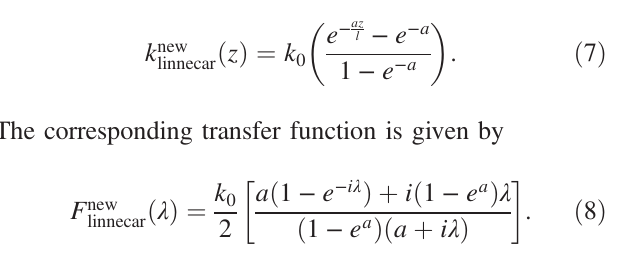
Figure 2 shows numerical comparison between F new ð λ Þ and F ð λ Þ . The red and the blue lines linnecar linnecar ð λ Þ =k j and j F ð λ Þ =k j , respectively. As show j F new 0 0 linnecar linnecar expected, the fluctuation is drastically reduced.